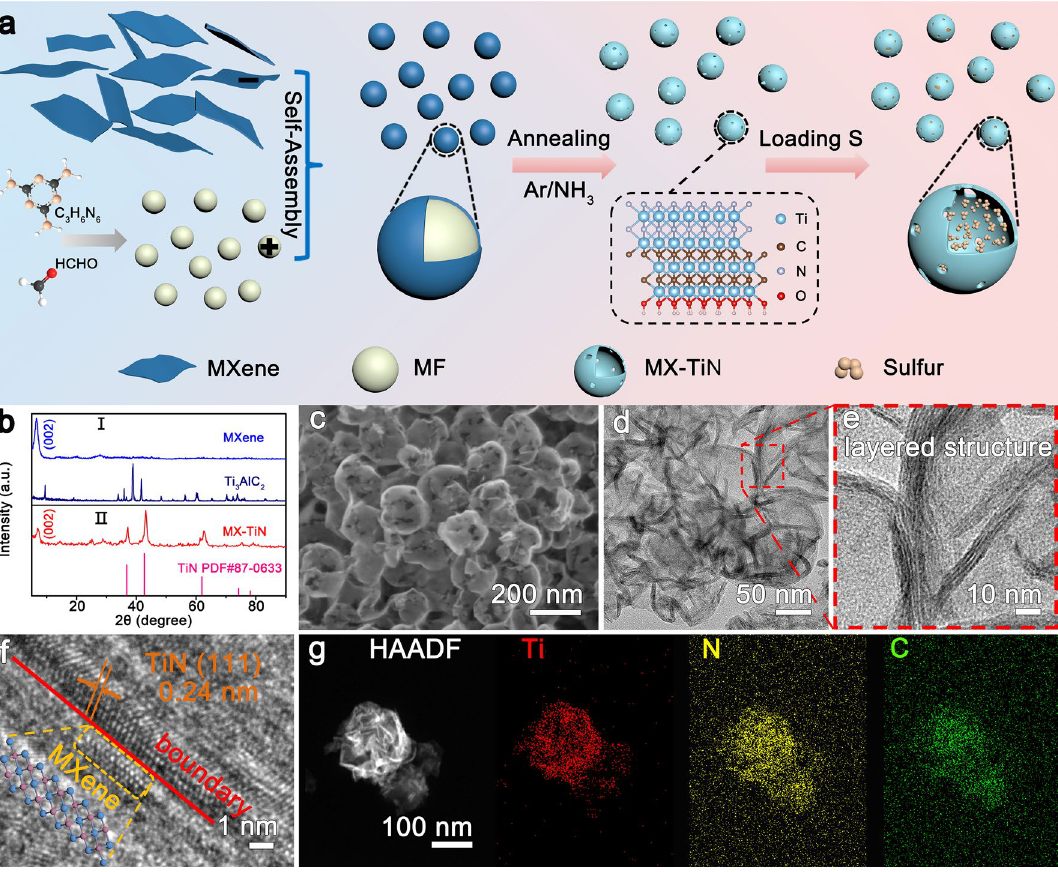
Fig. 1 a Schematic illustration of synthetic procedures for MX‑TiN and S/MX‑TiN hybrid. b XRD patterns of Ti 3 AlC 2 , Ti 3 C 2 T x MXene, and MX‑TiN. c SEM and d TEM images of MX‑TiN. e Enlarged TEM image of MX‑TiN. f HRTEM image of Ti 3 C 2 T x ‑TiN heterostructure. g HAADF‑STEM image and the corresponding elemental maps of